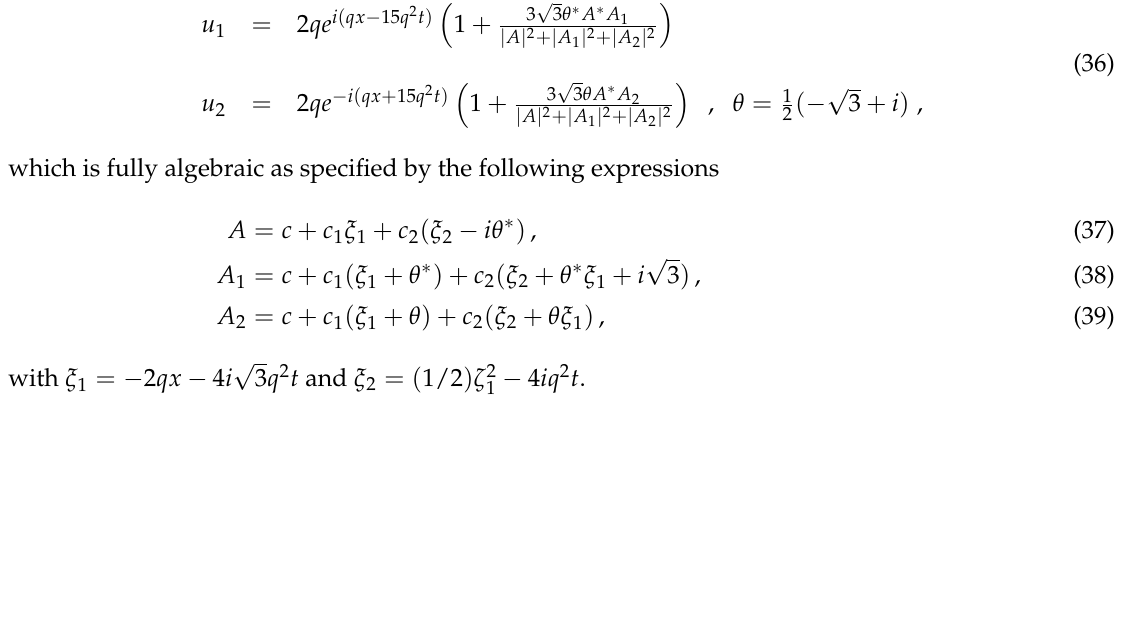
( x , t ) | / a = 2.9519, max | u RW ( x , t ) | / a = 2 1 2 1